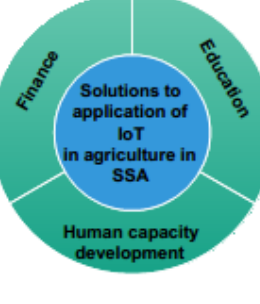
Figure 19. Solutions to the challenges in IoT application in agriculture in SSA